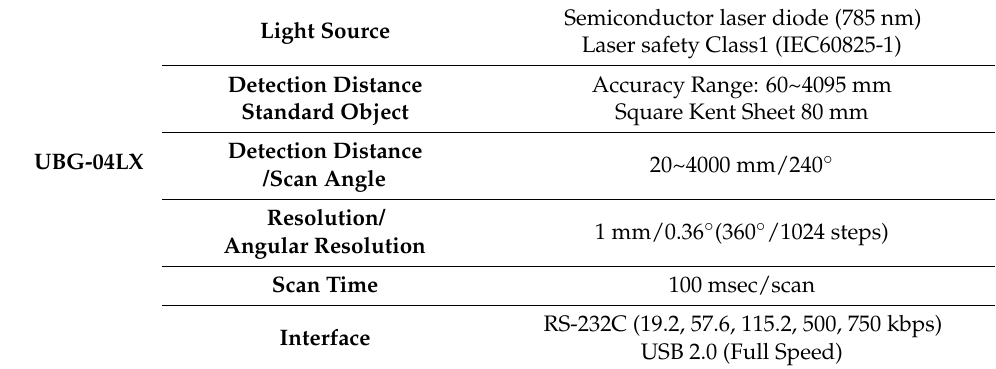
Table 1. Laser range finder: UBG-04LX.